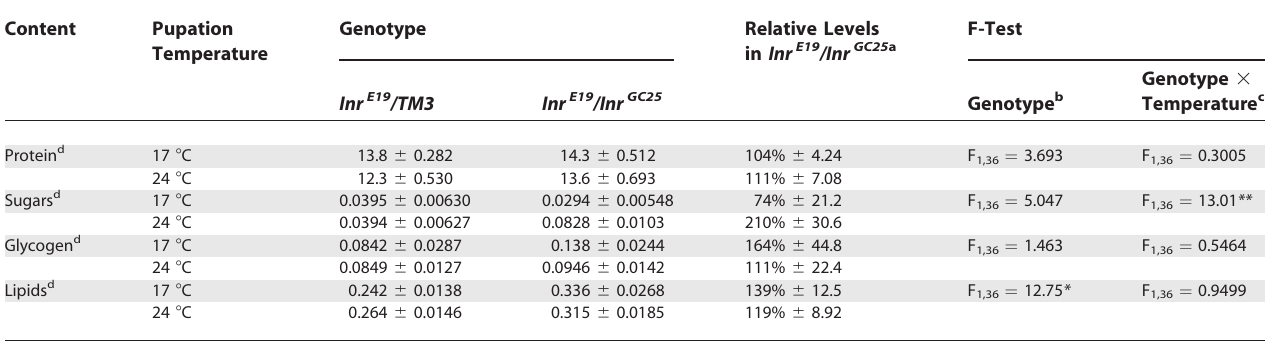
Table 1. Protein, Sugar, Glycogen, and Lipid Content of Inr E19 /Inr GC25 and Inr E19 / TM3 Flies Reared at 17 8 C until Pupariation and then Switched to 24 8 C or Maintained at 17 8 C Content